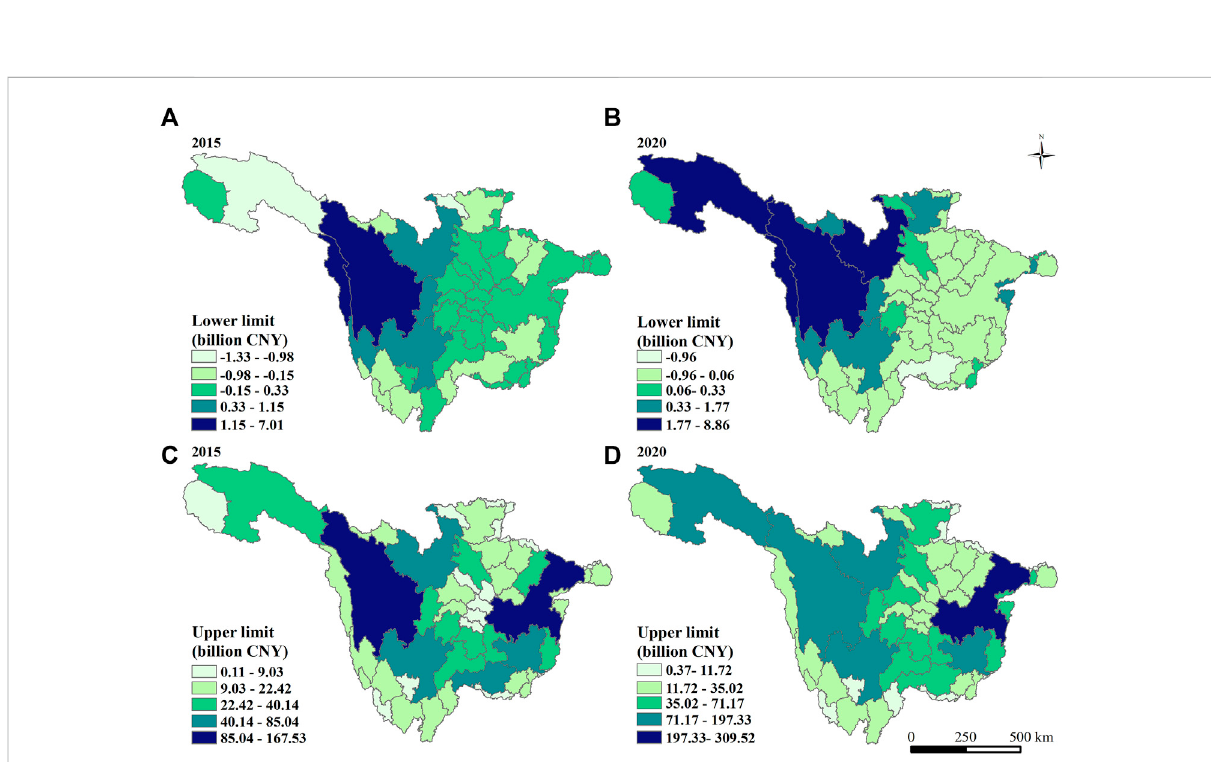
FIGURE 7 Total ecological compensation threshold inthe upper YangtzeRiver. (A) The lower limit of the total threshold of prefecture-level cities in2015; (B) Thelower limitofthetotalthresholdofprefecture-levelcitiesin2020; (C) Theupperlimit ofthetotalthresholdofprefecture-levelcitiesin2015; (D) The upper limit of the total threshold of prefecture-level cities in